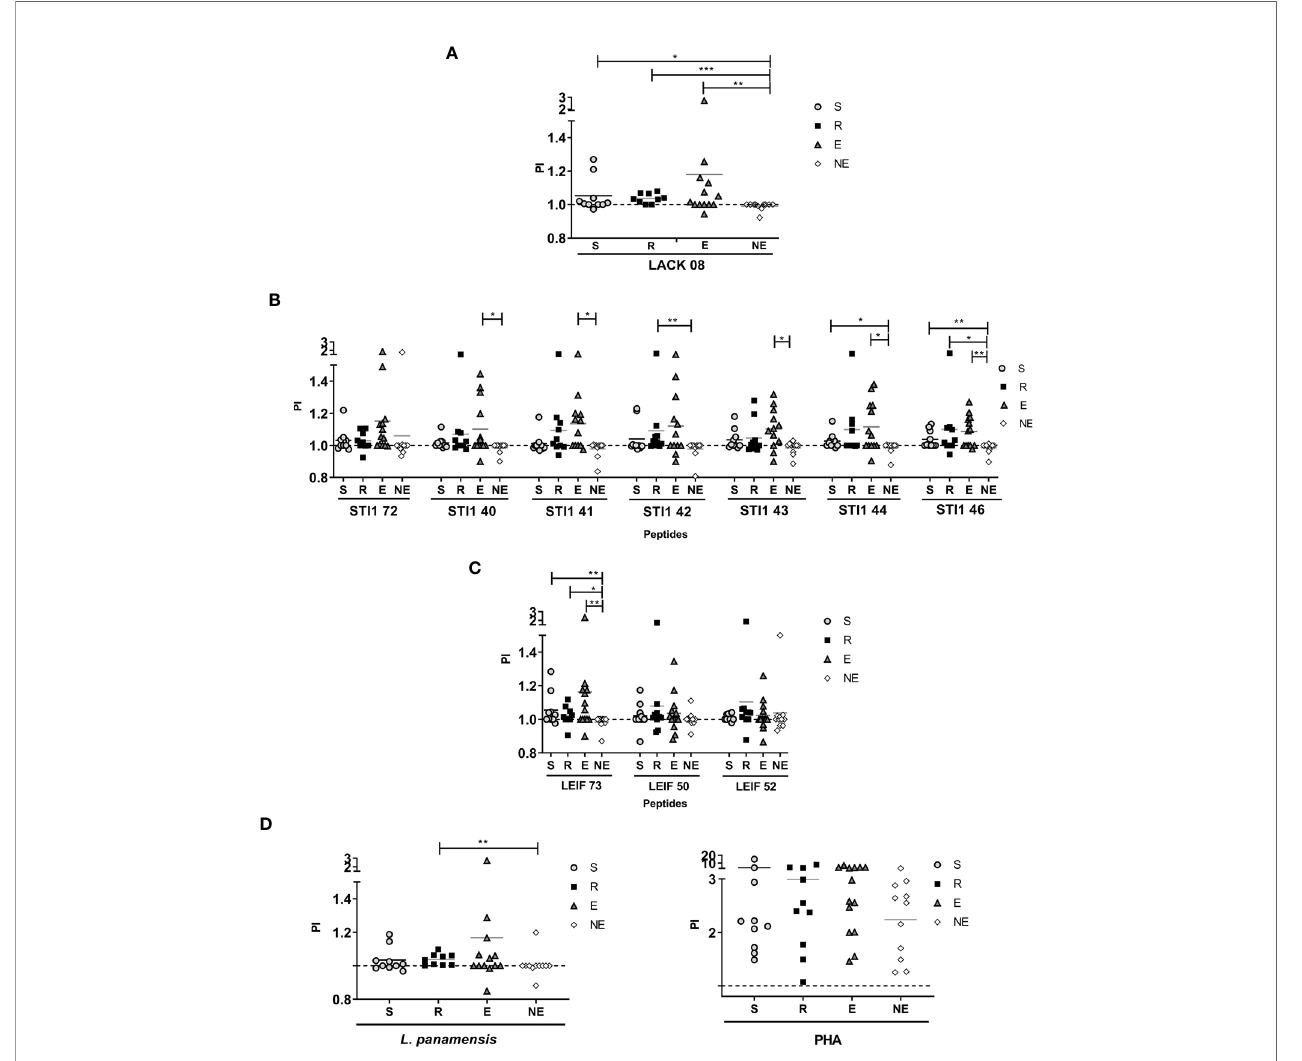
FIGURE 2 | Proliferation Index (PI) evaluated in S (susceptible), R (resistant), E (exposed), and NE (not exposed) groups. Cells response to (A) peptides derived from LACK protein; (B) peptides derived from STI1 protein; (C) peptides derived from LEIF, and (D) L. panamensis or PHA. p<0.05(*), P<0.01(**), P<0.001(***). Dashed line: non-stimulated cell